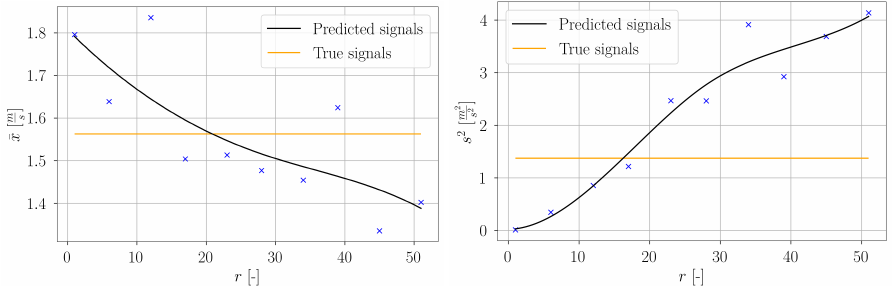
Figure 33. Total mean and variance of true and predicted signals (each averaged over all measurement points and all velocity components) depending on r .